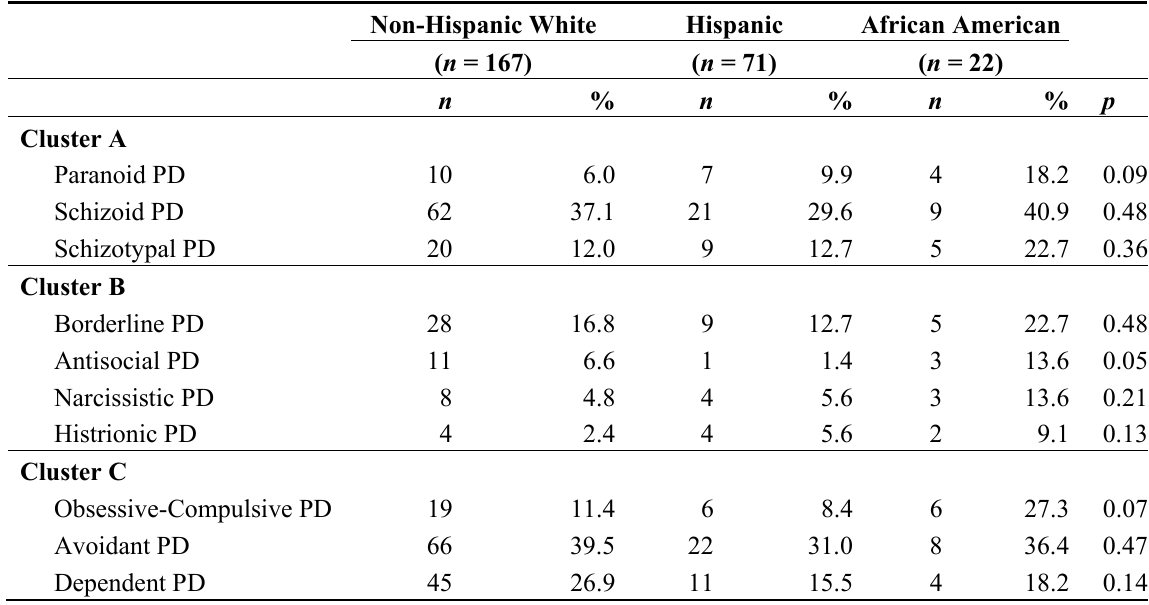
Table 1. Percentage meeting Millon Clinical Multiaxial Inventory-III (MCMI-III) diagnostic criteria for a personality disorder by ethnicity and